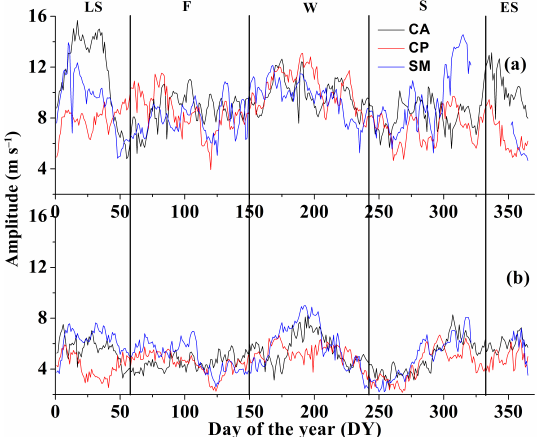
Figure 3. Vertical averaged amplitude of the QSDW in the MLT in the (a) zonal and (b) meridional winds for 3 stations.